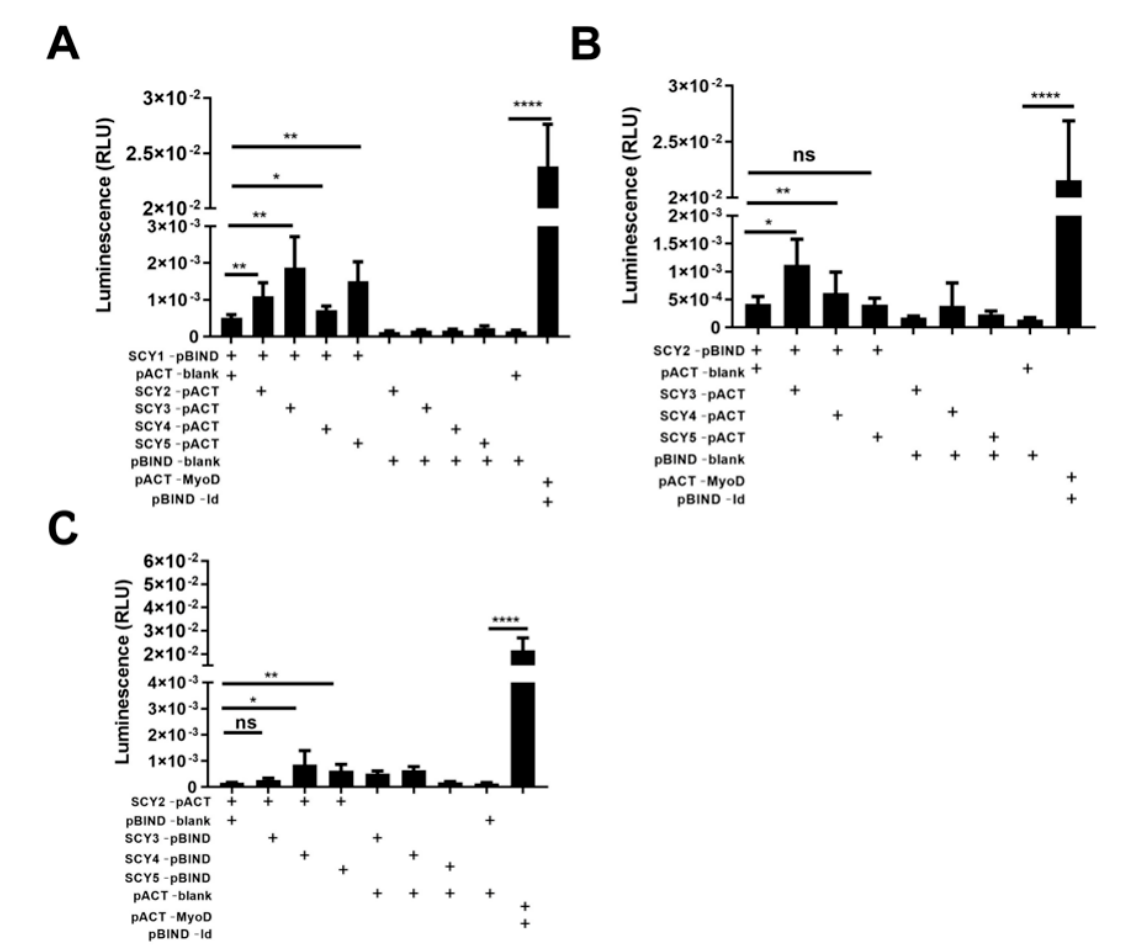
Figure 6. Verification of the rSCY1 and rSCY2, rSCY1 and rSCY3, rSCY1 and rSCY4, rSCY1 and rSCY5,